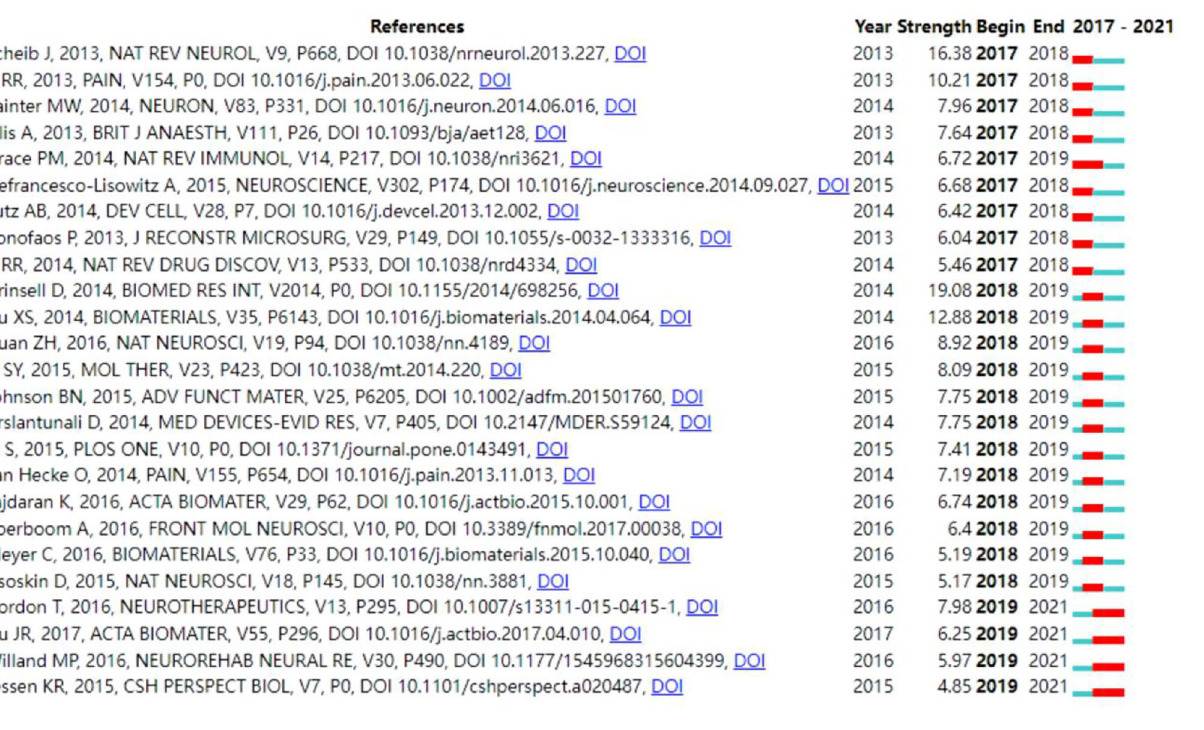
FIGURE 7 | TOP 25 References with the strongest citation